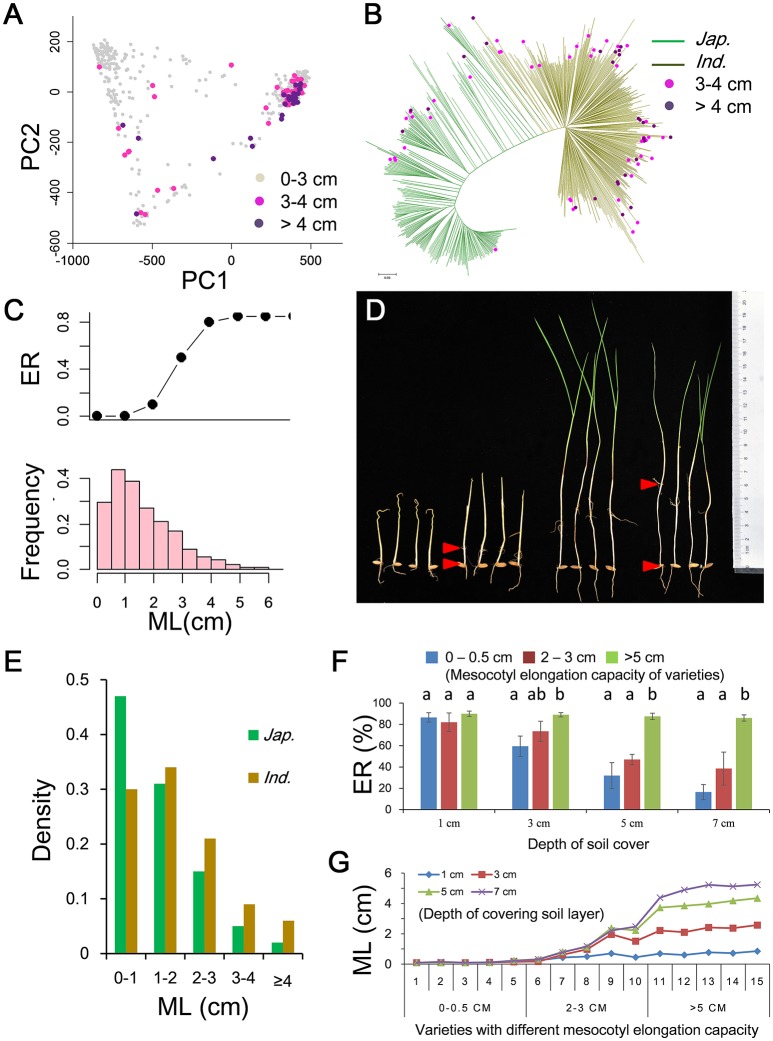
Mesocotyl lengths (MLs) in 621 cultivated rice and relationship among ML, emergence rate (ER) and planting depth. (A) Principal component plot and distribution of accessions with different ML. (B) Neighbor-joining tree and distribution of accessions with ML of more than 3 cm on the tree. (C) Relationship between ER and ML (upper) and histogram of ML (lower) in field plantings with 10 cm of soil cover. (D) Differentiation of MLs in cultivated accessions. (E) Comparison of MLs of indica and japonica. (F) Relationship between ER and ML in box plantings with different depths of soil cover. Different letters above bars indicate significant differences (p < 0.05) detected by Duncan's multiple range test. (G) Relationship between ML and depth of soil cover for accessions with different mesocotyl elongation capacities.